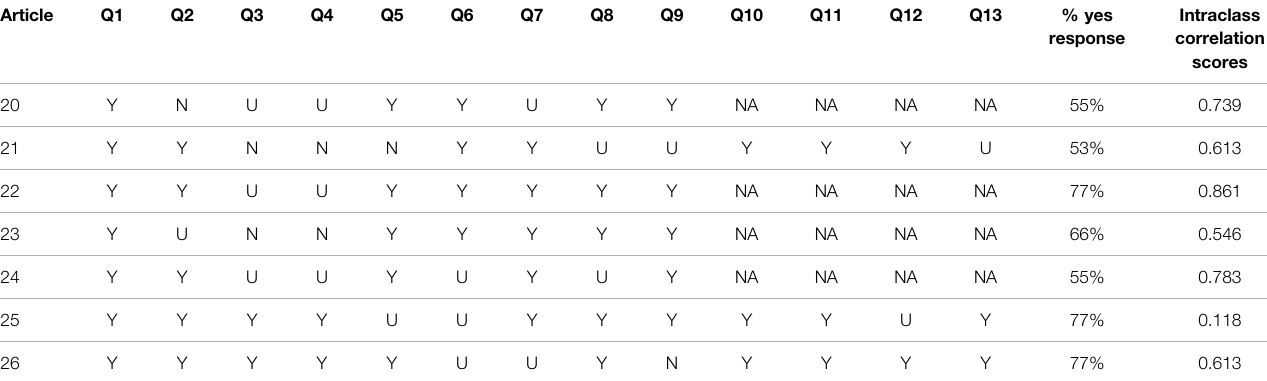
TABLE 5 | Critical appraisal of eligible